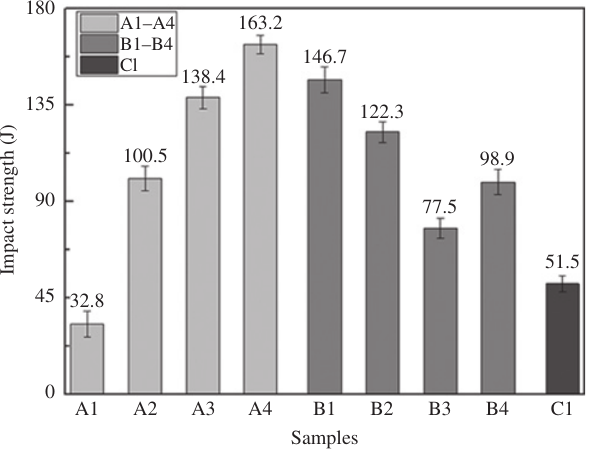
Figure 7: The impact strength of all the